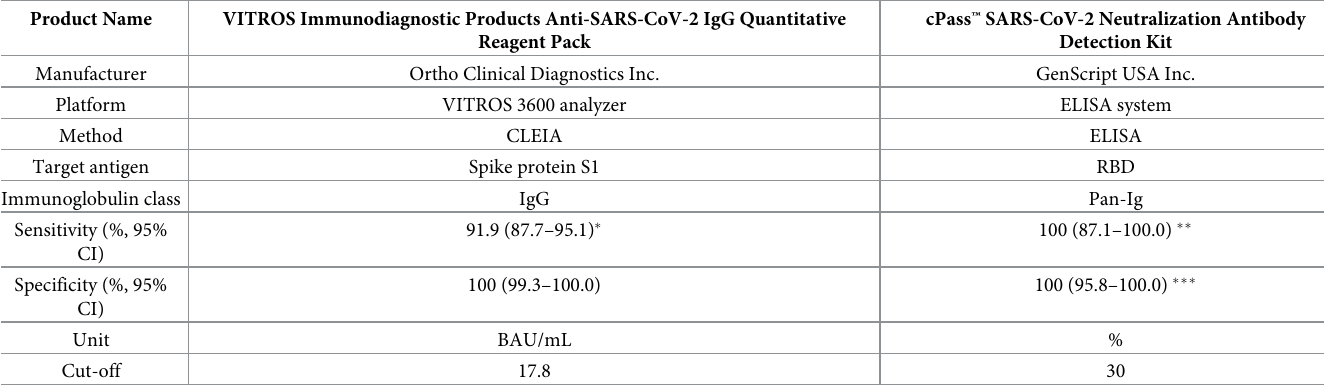
Table 1. Specifications of VITROS S-IgG and cPass